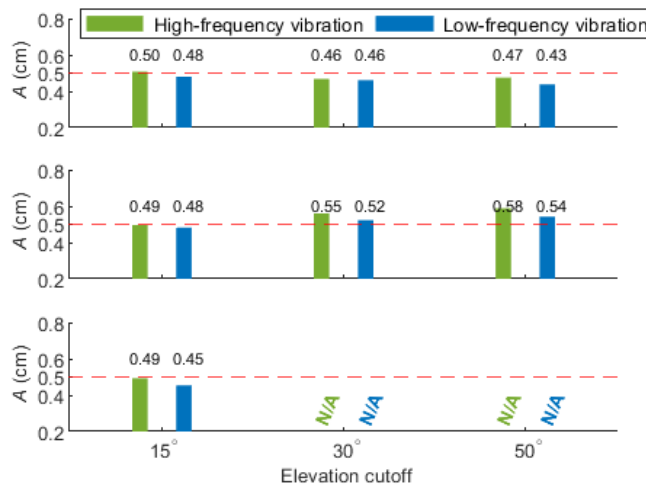
Figure 18. Amplitudes of the vibrational behaviors at levels of masking conditions. The five- = ± 9 cm is adopted during the process. The top , middle and bottom constellation PCPPP with σ b c panels refer to the E, N and U directions,